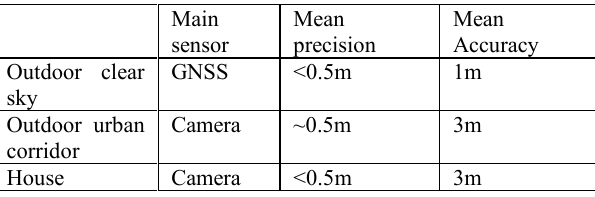
Table 2 . IOPES system horizontal performance at “Garraf- town” test site.